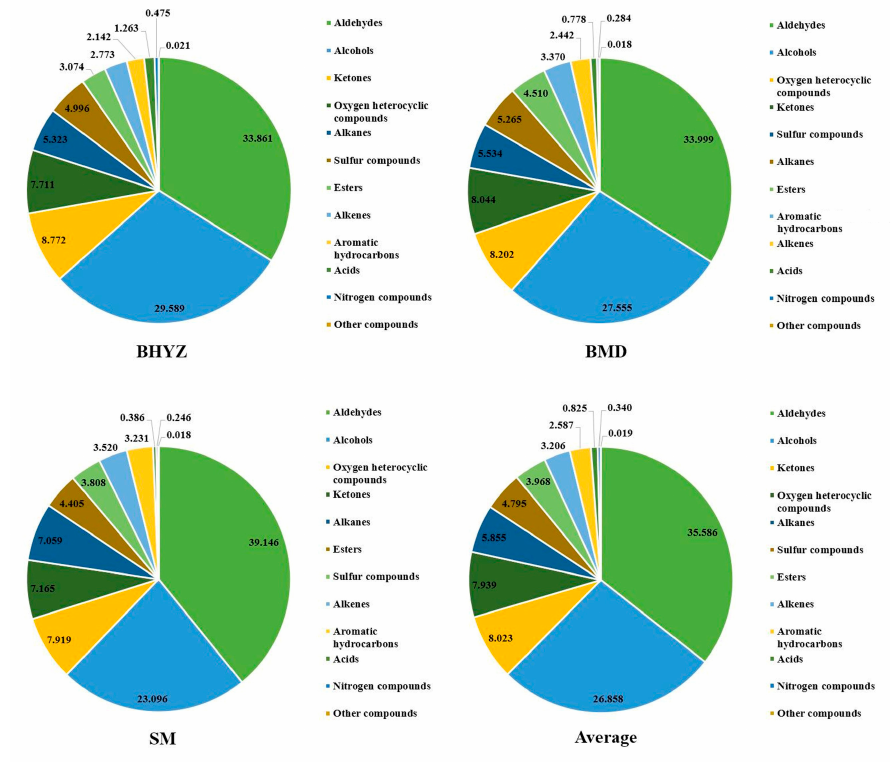
ff erent kinds of volatile compounds in white Figure 1. The content level distributions (%) of different kinds of volatile compounds in white teas. Figure 1. The content level distributions (%) of di